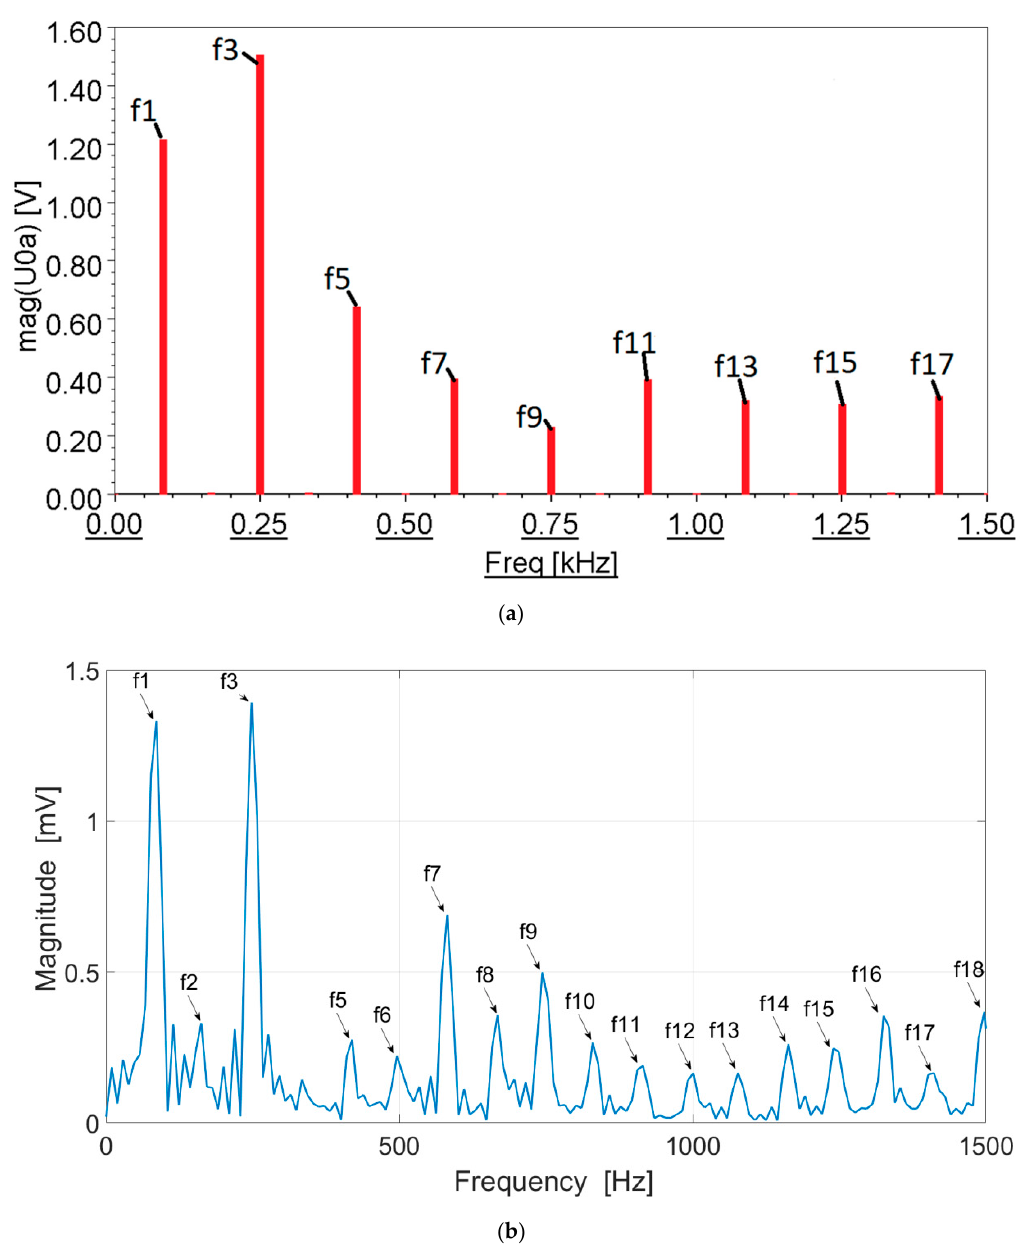
Figure 11. Star (Y)—FFT of neutral voltage star configurations of open circuits (OCs): ( a ) numerical calculations; ( b ) measurement.